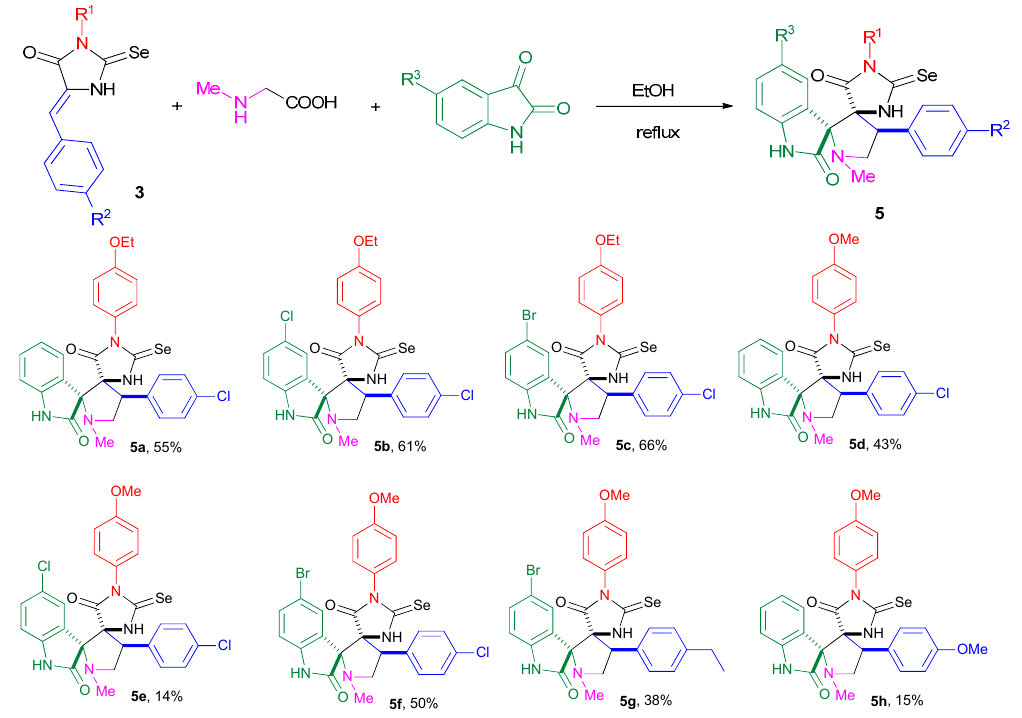
Scheme 4. Synthesis of dispiroselenohydantoins 5a-h .